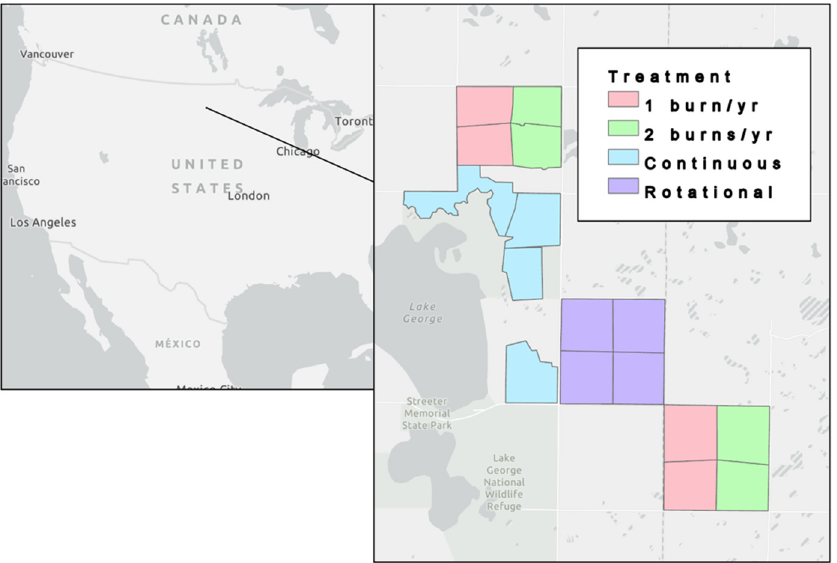
Figure A1. Location of study within the United States; (inset map) layout of experimental treatment pastures.